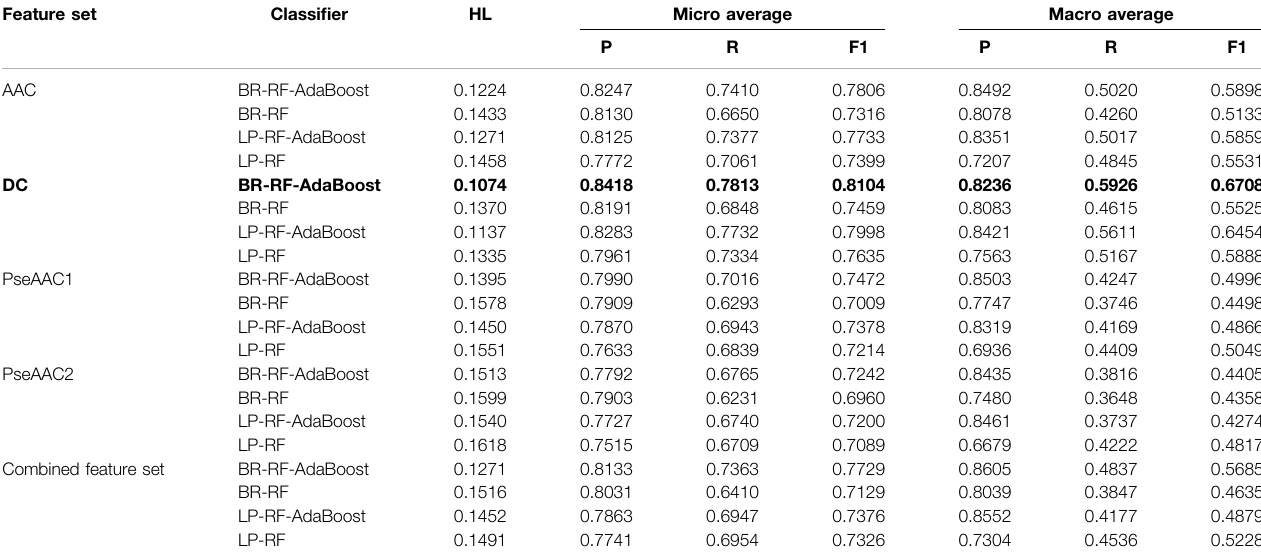
TABLE 6 | Average prediction performance for test sets (Note that the best performing model is shown in bold). Feature set